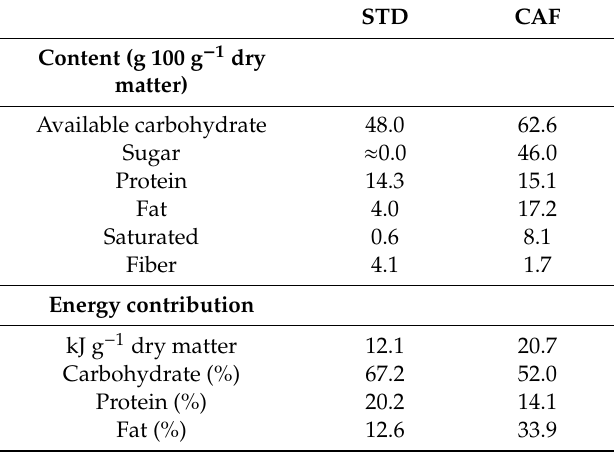
Table 1. The composition and energy content of diets